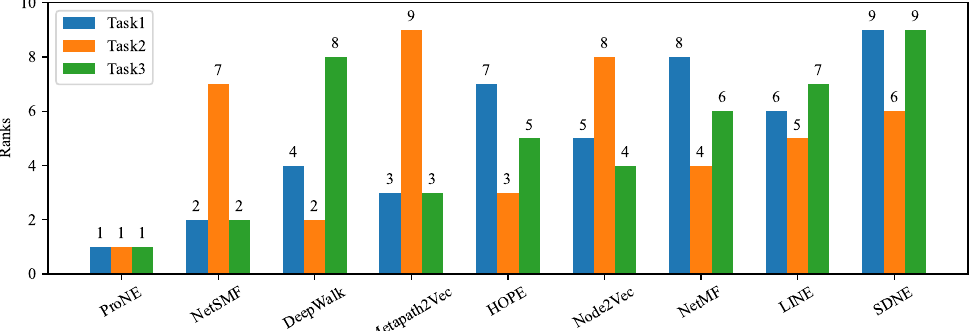
Figure 3. Overall rank of unsupervised NRL algorithms for pure networks, evaluated by FURL. We visualize the ranks of each selected pure network embedding algorithm using a bar chart. The algorithms are sorted by their overall ranks in ascending order, from left to